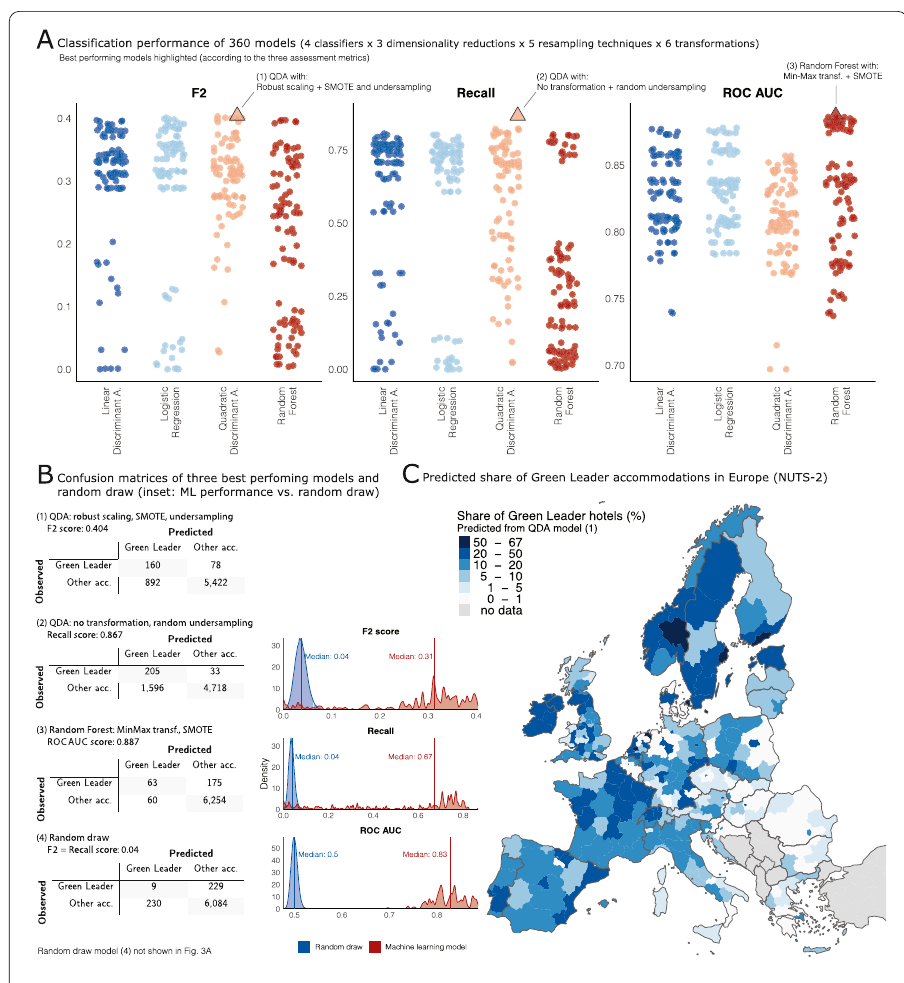
Figure 3 Classification performance and extrapolation. ( A ) Comparison of 360 classification models (90 models per classifier and panel) regarding three performance metrics: F2 score, Recall, and ROC AUC (each dot represents a model). QDA model (1) shows the highest F2 score, QDA model (2) achieves the highest Recall, and Random Forest model (3) the best ROC AUC score. ( B ) Confusion matrices of the three best performing models (1) to (3) according to the performance metrics (top panels) and a random draw model (4) (lowest panel). Inset: performance comparison between machine learning models (red) and 20,000 random draws (blue) according to F2 score, Recall, and ROC AUC. The machine learning models show a significantly better prediction performance than the random draw models. ( C ) Predicted share of